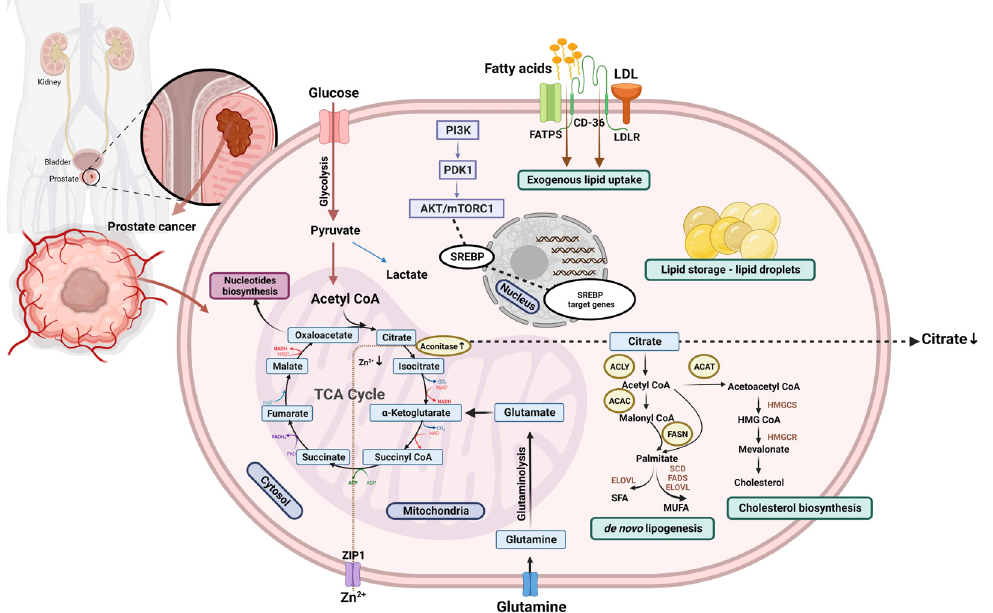
Figure 1. Graphical presentation of lipid reprogramming in prostate cancer. ACAC, acetyl-CoA carboxylase; ACAT, acetyl-CoA acetyltransferase; ACLY, ATP-citrate lyase; CD36, CD36 molecule; ELOVL, elongation of very long lipids protein; FASN, fatty acid synthase; FADS, fatty acid desaturase; FATPs, fatty acid transport proteins; HMGCR, 3-hydroxy-3-methylglutaryl-CoA reductase; HMGCS, 3-hydroxy-3-methylglutaryl-CoA synthase; LDL, low-density lipoprotein; LDLR, low-density lipoprotein receptor; MUFA, monounsaturated fatty acids; SCD, stearoyl-CoA desaturase; SFA, saturated fatty acids; SREBP, Sterol regulatory element binding transcription factor; TCA, tricarboxylic acid cycle.